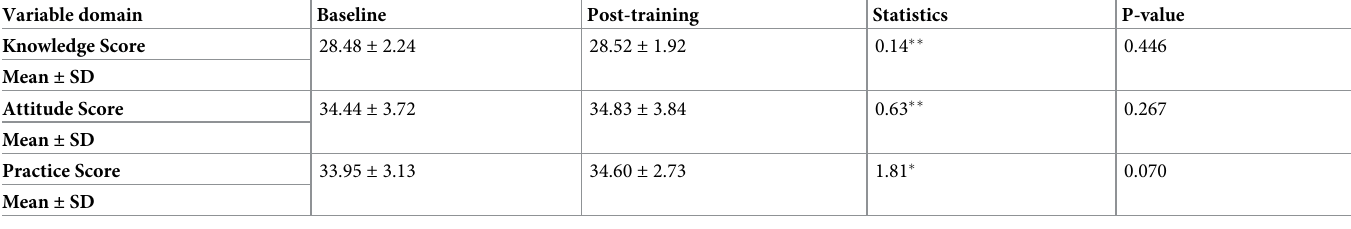
Table 3. Pre-and post-training knowledge attitude and preventive practices scores of PHC workers.